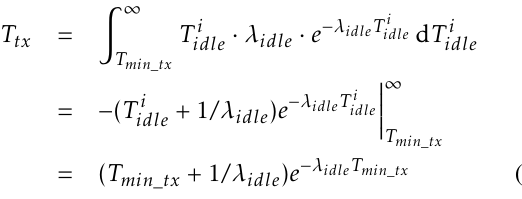
Figure 2. PU channel ON/OFF two-state Markov Renewal Model. p denotes the probability of state transition from ‘busy’ to ‘idle’; q denotes the probability of state transition from ‘idle’ to ‘busy’.